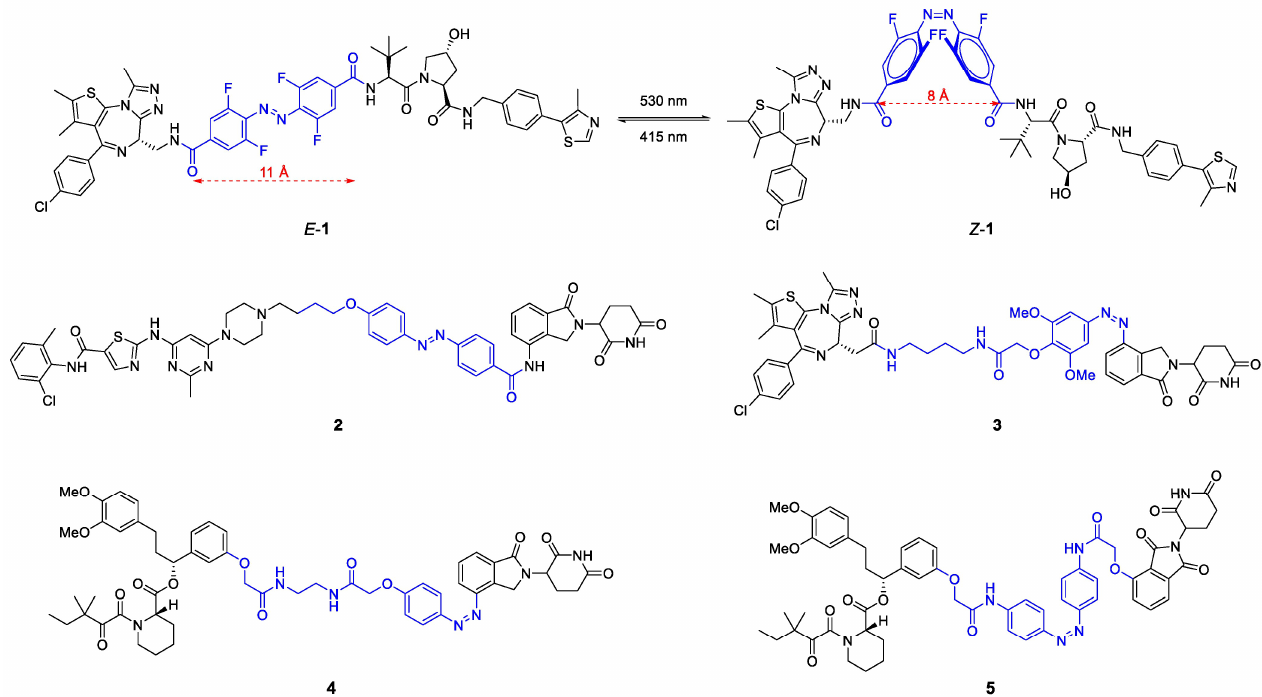
Figure 6. Chemical structure of photoswitchable PROTACs 1 – 5 . The linker containing the light-responsive azo group is highlighted in blue color. All molecules can be precisely converted to either the E - or Z -isomer of which only the active degrader is shown for 2 – 5 .